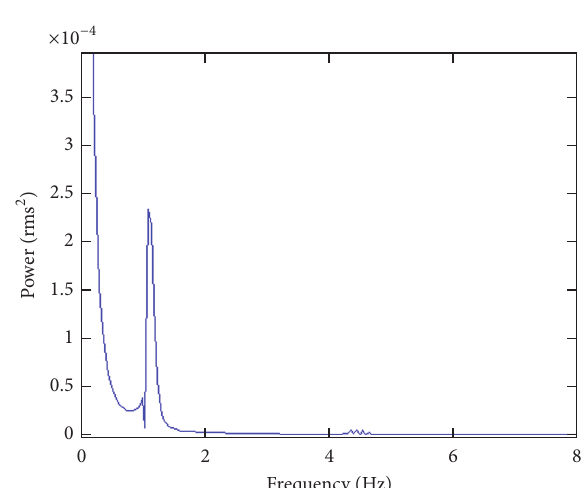
Figure 4: FFT spectrum of the response of undamaged beam with mass velocity for 1